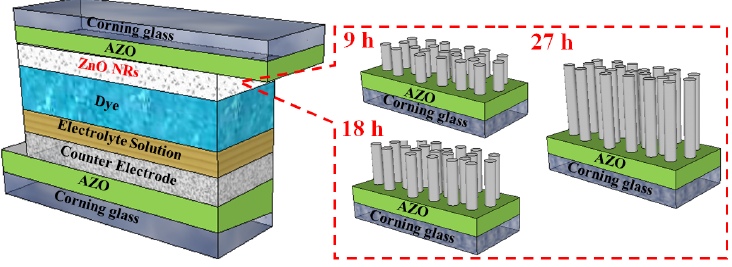
Figure 1. The schematic illustrations of DSSCs with ZnO nanorods.